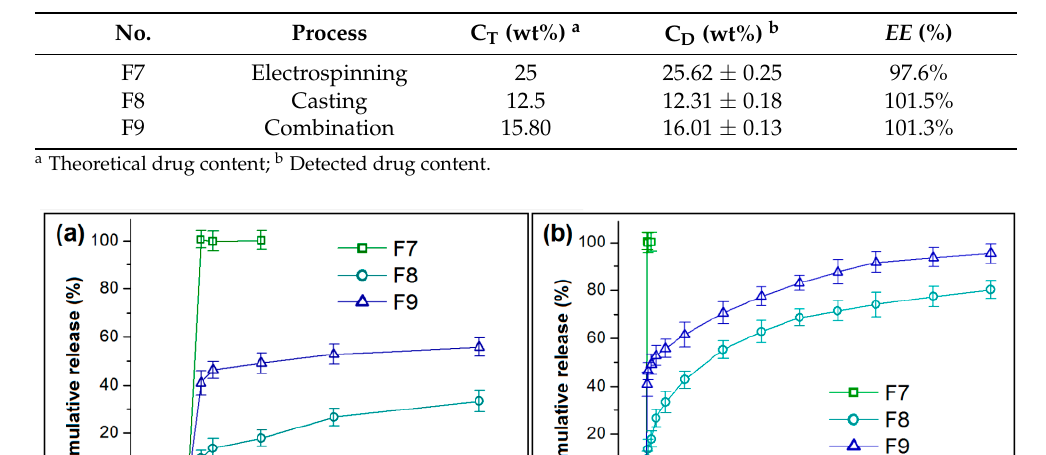
Table 2. Drug content in different prepared nanofibers ( n = 3).